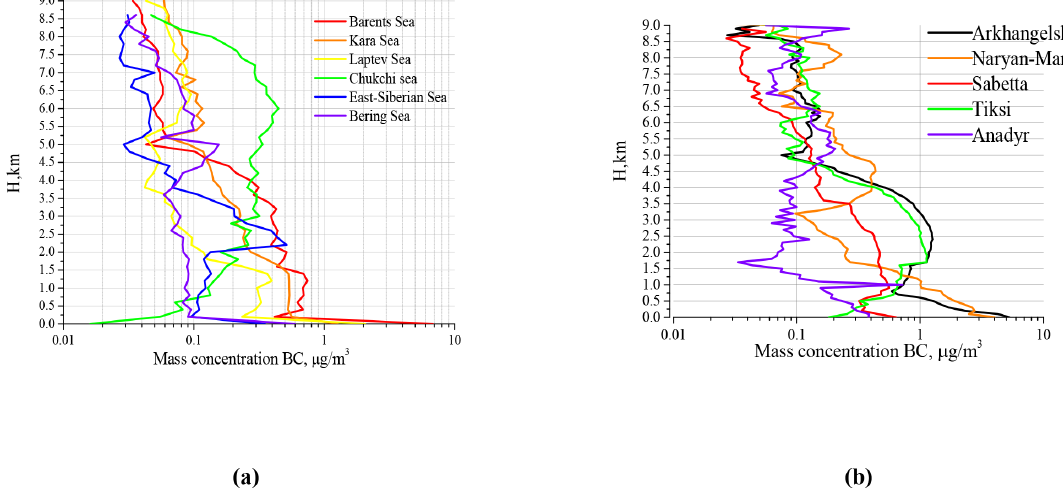
Figure 20. Vertical profiles of the eBC mass concentration on 4–17 September 2020: over (a) sea and (b) coastal areas. Table 7. Water extinction coefficient in the upper layer of the ocean and the presence of organic matter in the seas of the Russian sector of the Arctic. Sea Extinction, m − 1 LIF, rel.units